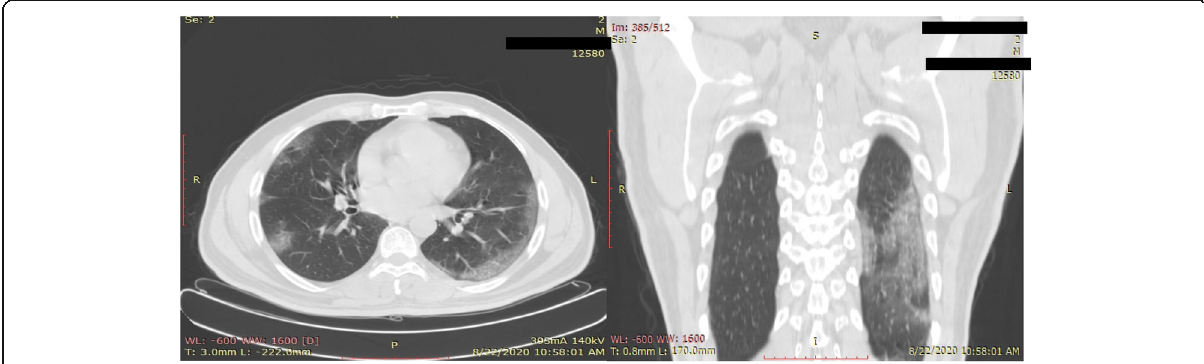
Fig. 2 A 36-year-old male patient with positive PCR test. Chest CT shows bilateral ground glass opacities in a peripheral/subpleural distribution with lung involvement of 5 – 25%, i.e., CT severity score of